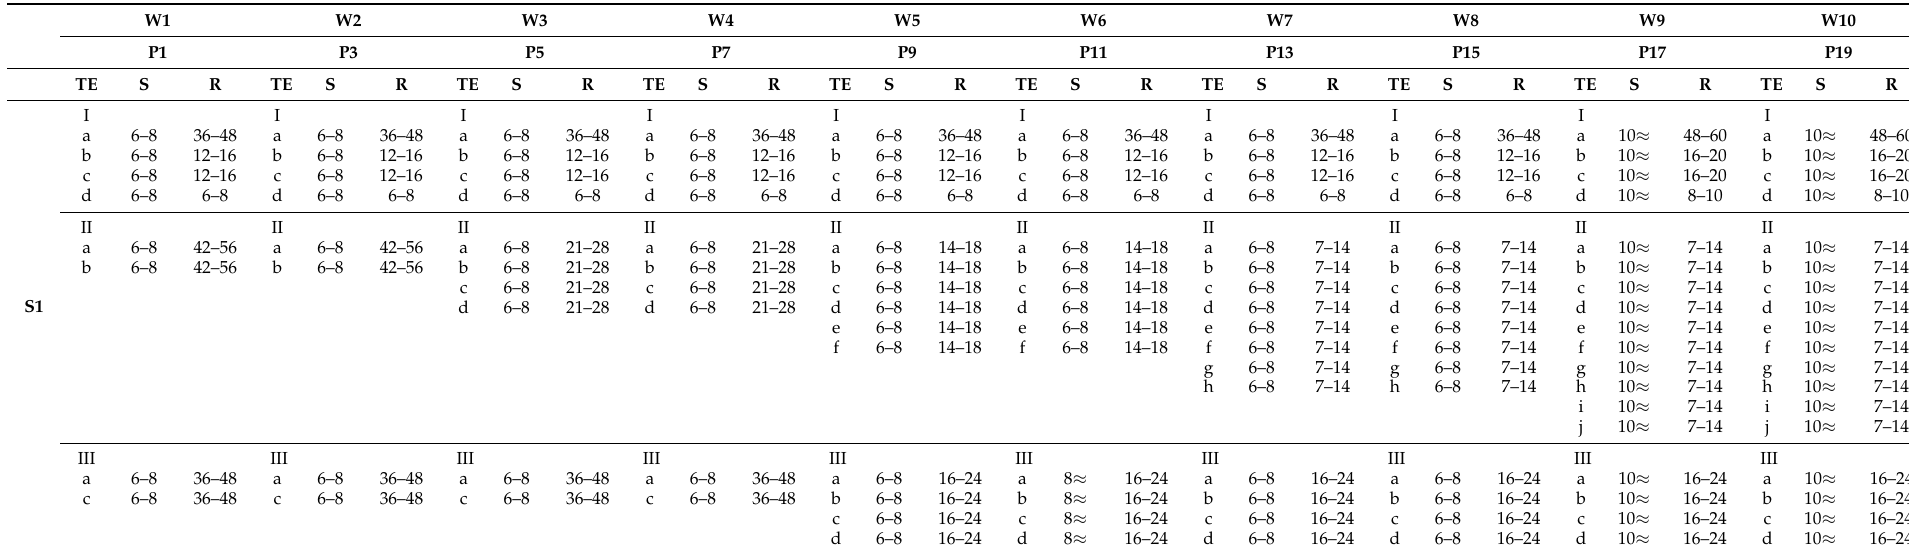
Table 1. Intervention program. Description of 10-Week Combined Coordination and Agility Training Program on Young Male Soccer